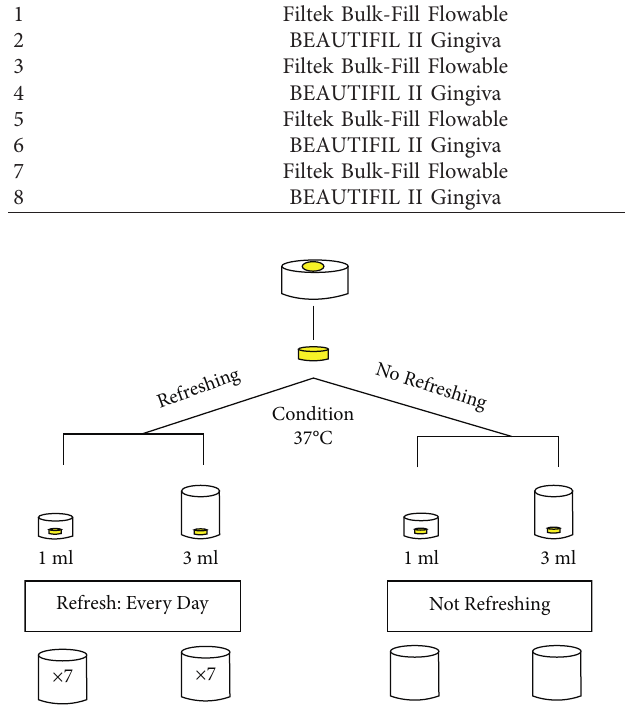
Figure 1: Schematic illustration of the research method used in this